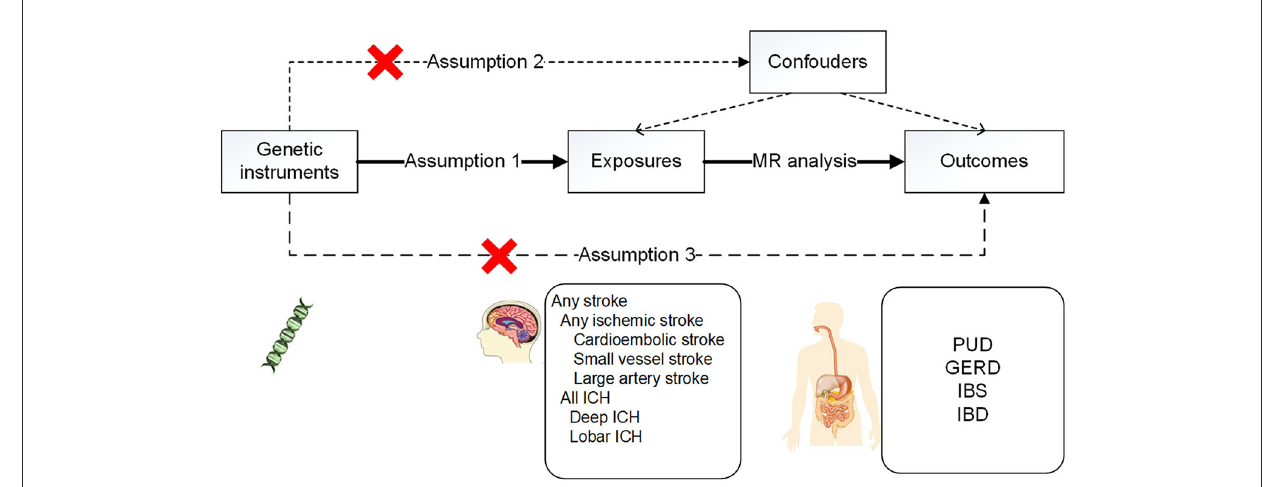
FIGURE1 Conceptual MR